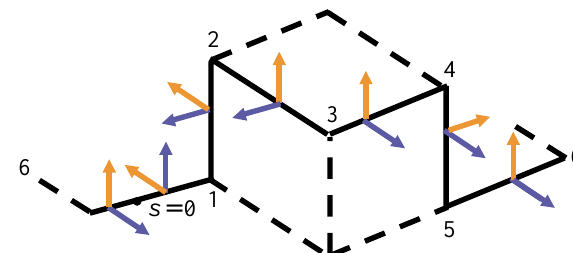
FIG. 1. (Color) The parallel transport and the twist. The point s (cid:1) 0 is indicated by a full circle. The magnets (arcs) are num- bered. Magnet #6 corresponds to a long planar arc. The unit vectors ˆ e x (dotted arrow) and ˆ e y (solid arrow) are defined arbi- trarily at s (cid:1) 0 1 , and parallel transported along the reference orbit shown. As they get back to s (cid:1) 0 2 after a complete turn, they are tilted by an angle F (cid:1) p (cid:3) 2 in the example.